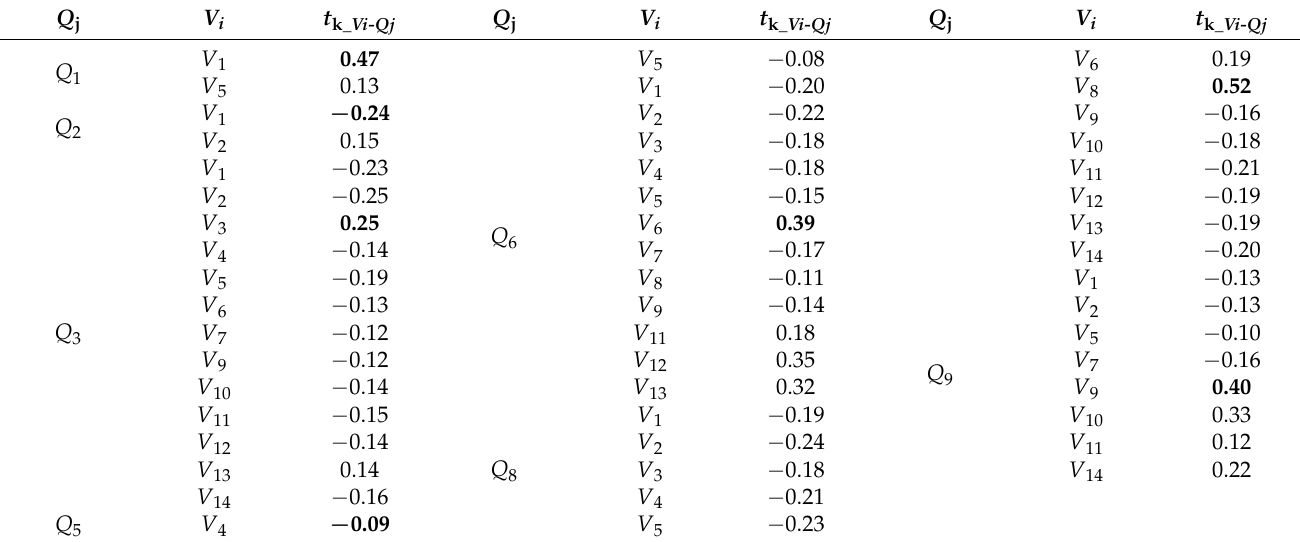
Table 5. Values of KRCCs Characterizing SSCRs between Nodal Reactive Powers and Nodal-Voltage Magnitudes ( α = 0.01).